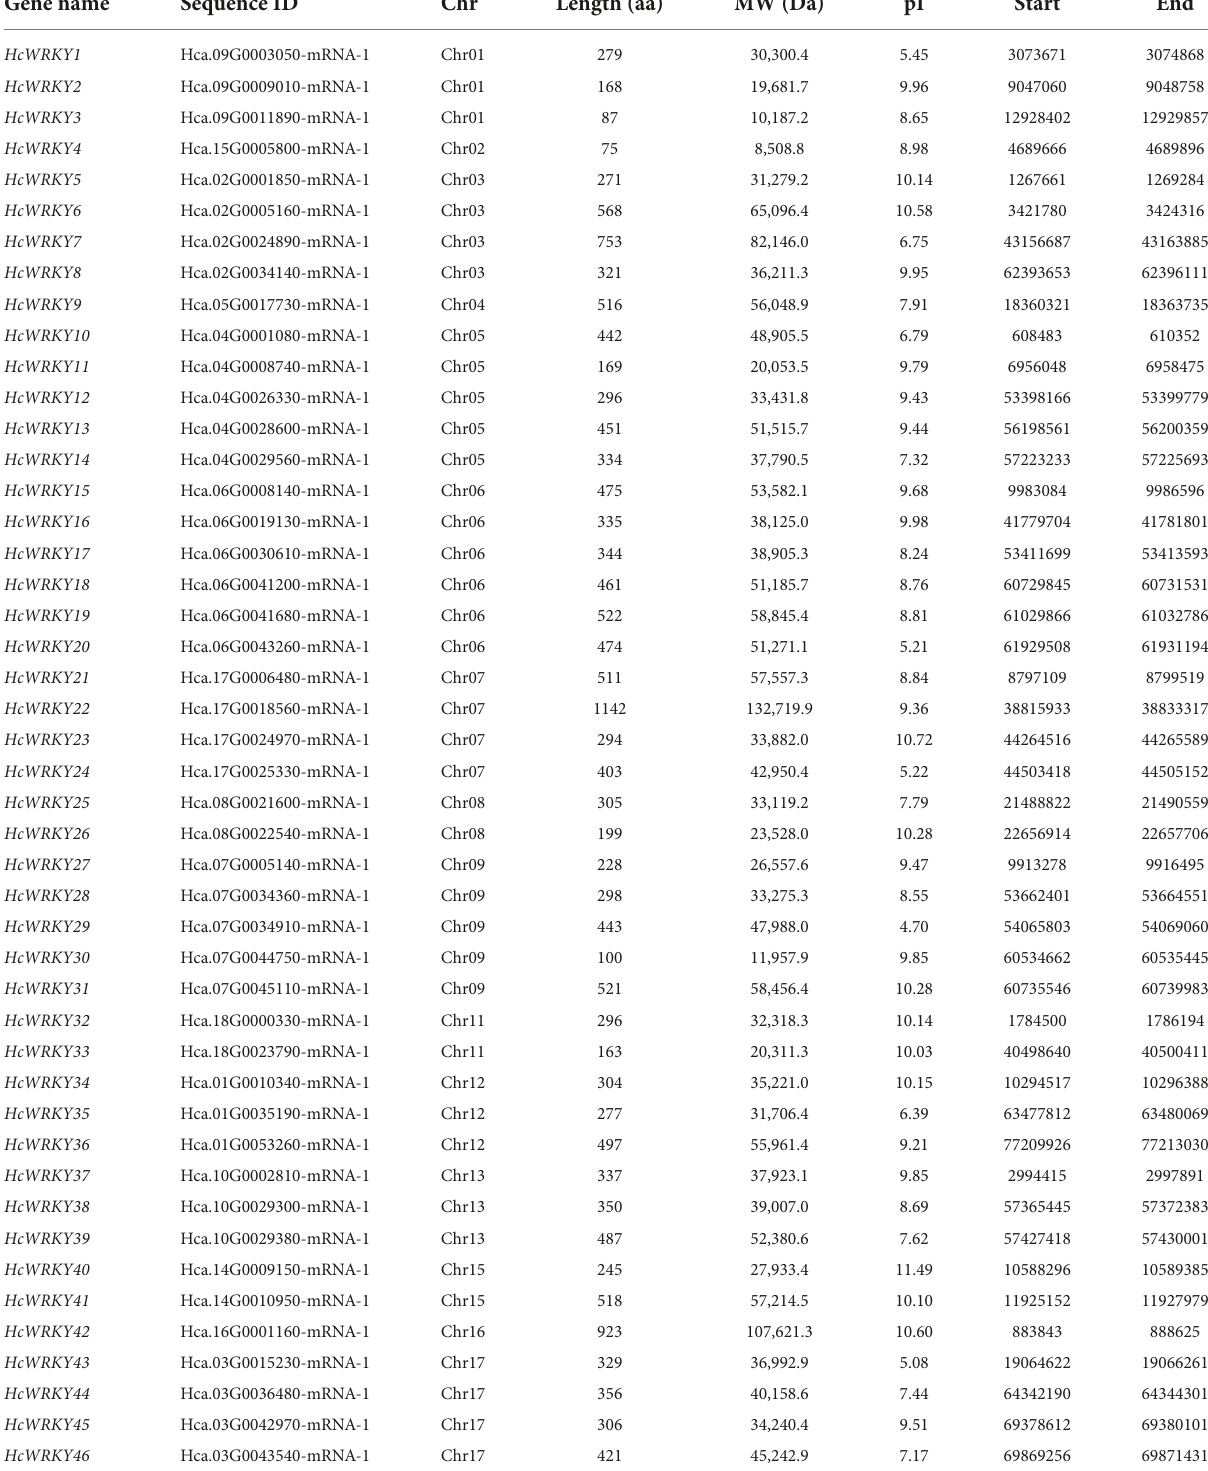
TABLE 1 Protein information of WRKY genes in Hibiscus cannabinus